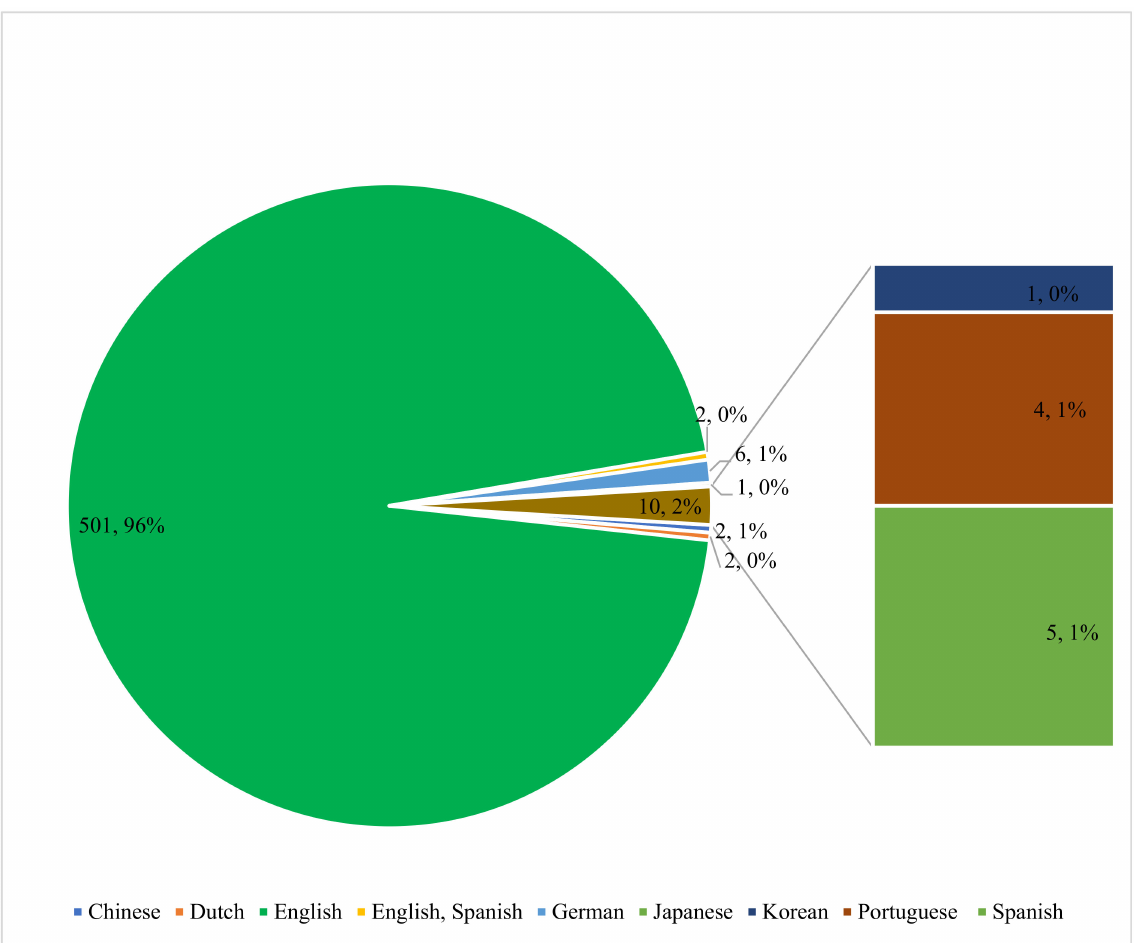
Figure 2. The language diversity of Arcobacter